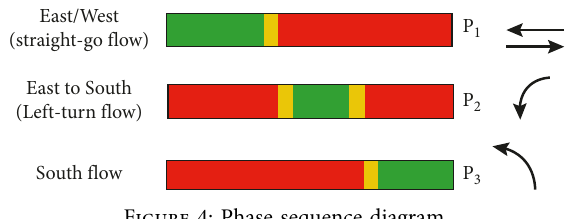
Figure 4: Phase sequence